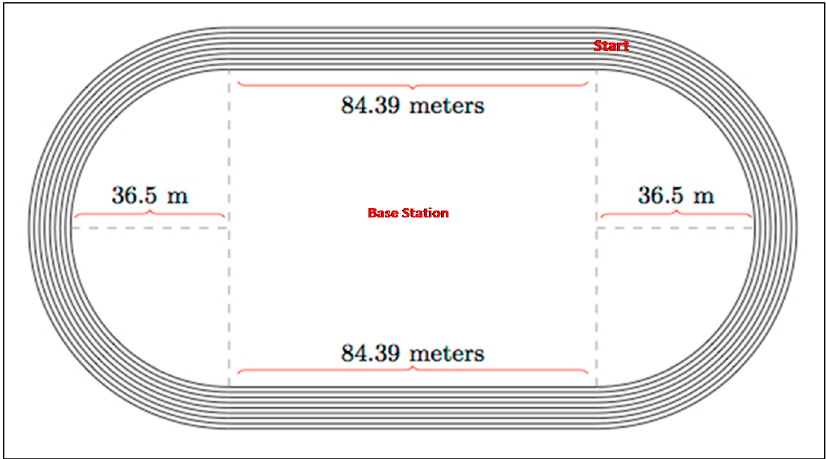
Figure 8. Shape and dimension of a standard Olympic track.